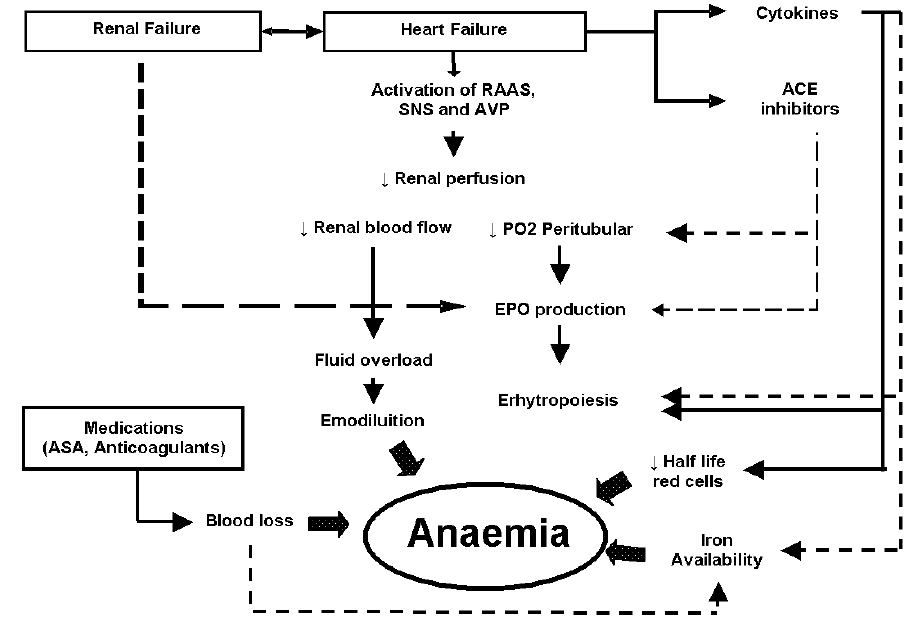
RAAS: Renin-Angiotensin-Aldosterone System; SNS: Sympathetic nervous System; AVP Arginine Vasopressin; ACE: angiotensin converting enzyme inhibitor; PO2: oxigen partial pressure; EPO: erythropoietin; ASA: acetyl salicylic acid